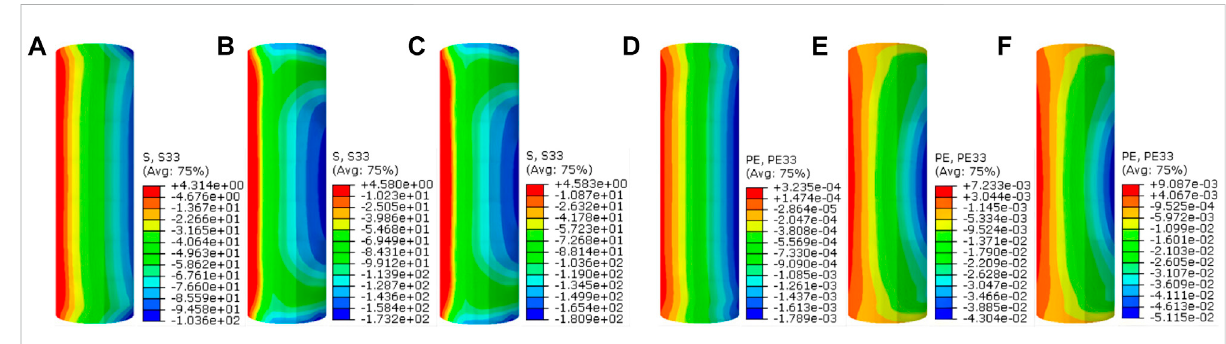
FIGURE 11 Distribution of longitudinal stresses and longitudinal strains of concrete at each loading stages of typical specimen HCHST-6: (A) Longitudinal stress distribution of concrete at elastic stage; (B) Longitudinal stress distribution of concrete at elastic-plastic stage; (C) Longitudinal stress distribution of concrete at plastic stage; (D) Longitudinal strain distribution diagram of concrete at elastic stage; (E) Longitudinal strain distribution diagram of concrete at elastic-plastic stage; (F) Longitudinal strain distribution diagram of concrete at plastic stage.